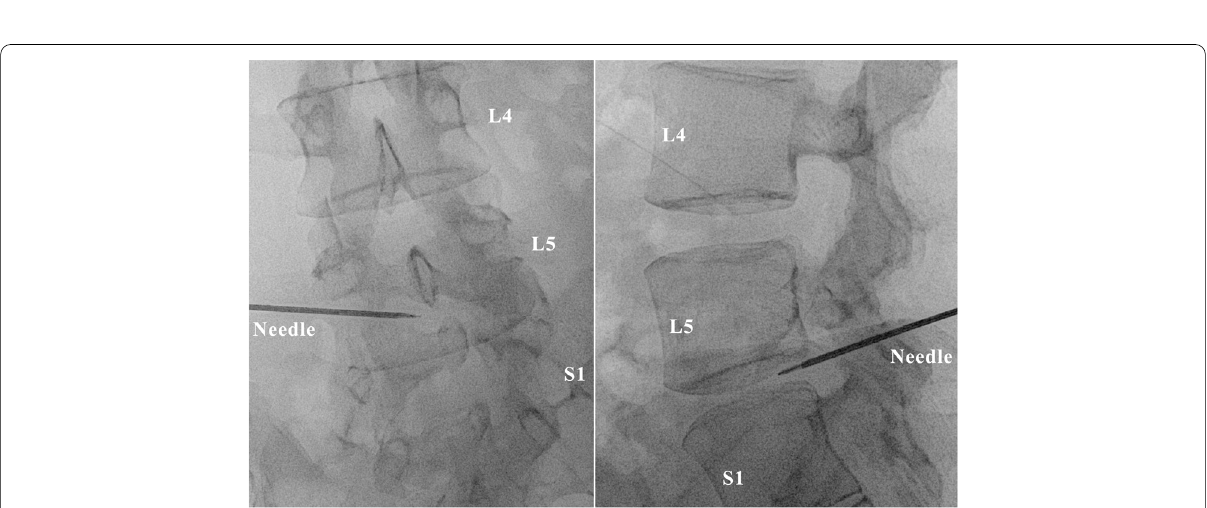
Fig. 4 Live fluoroscopy for needle deployment. The tip of the needle is confirmed at the anteroposterior and lateral